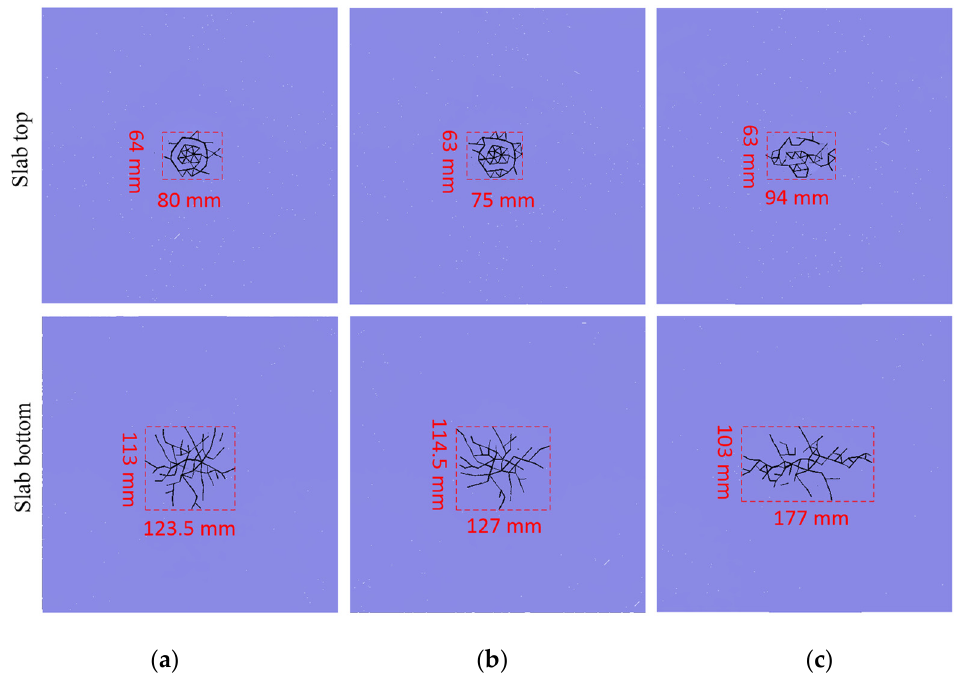
Figure 4. Crack distribution on mortar slab under differently shaped hammerheads: ( a ) circular hammer impact; ( b ) square hammer impact; ( c ) rectangular hammer impact.